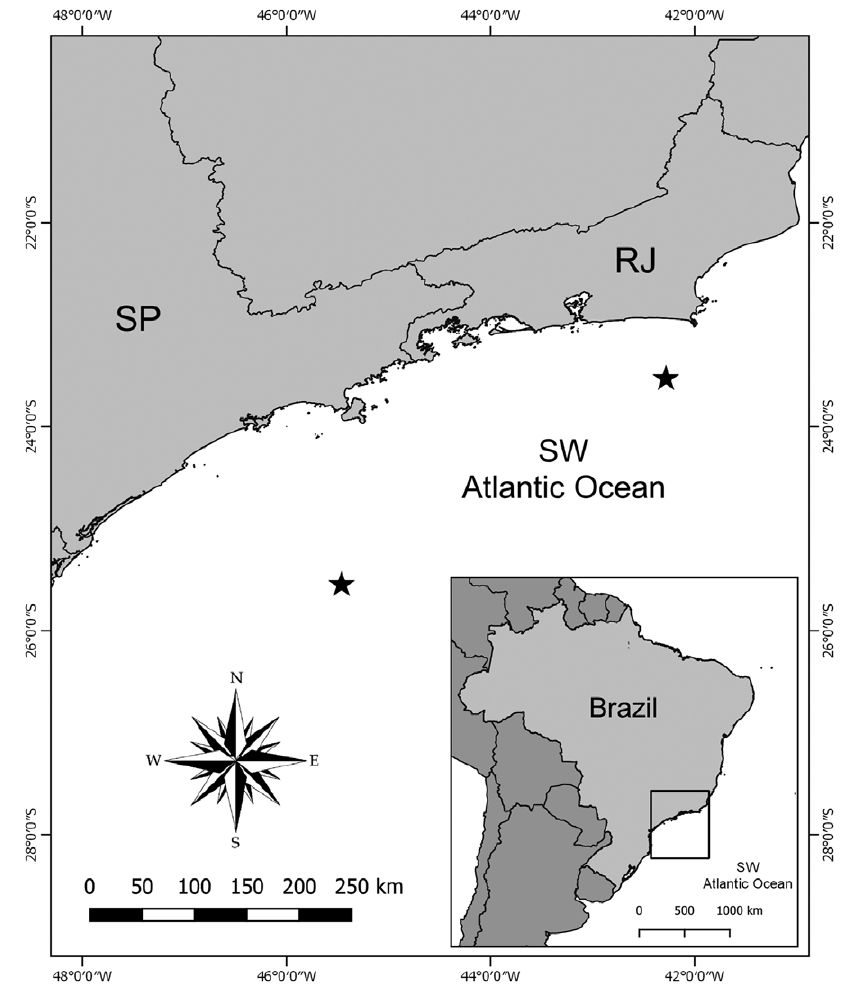
Fig. 6. – Distribution of Atlantiphoxus wajapi n.